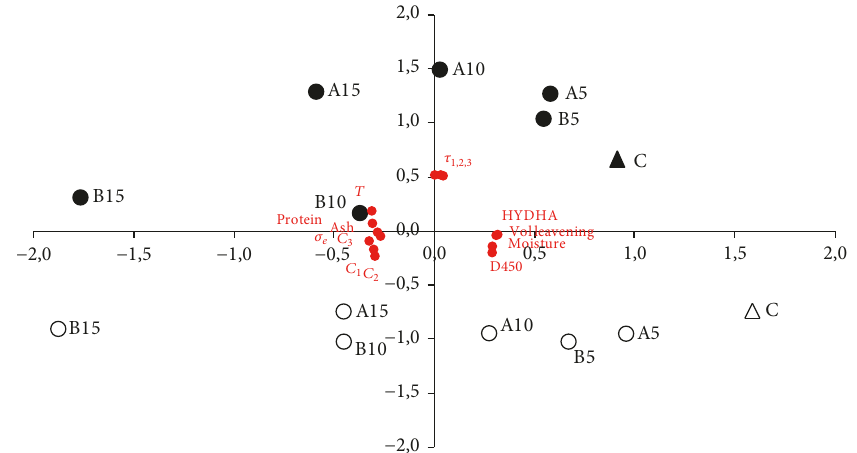
Figure 2: Principal component analysis (based on the correlation matrix) of the dough samples. Biplot of factor scores (points). 4T control ( △ ); 48T control ( 󳵳 ); 4T dough with ovine whey powder (A, B) ( I ); 48T dough with ovine whey powder (A, B) (black circle); loadings (red circle). Stress relaxation test parameters: 𝐶 1 , 𝐶 2 , and 𝐶 3 : decay force of the Maxwell model; 𝜏 1 , 𝜏 2 , and 𝜏 3 : relaxation times of the Maxwell